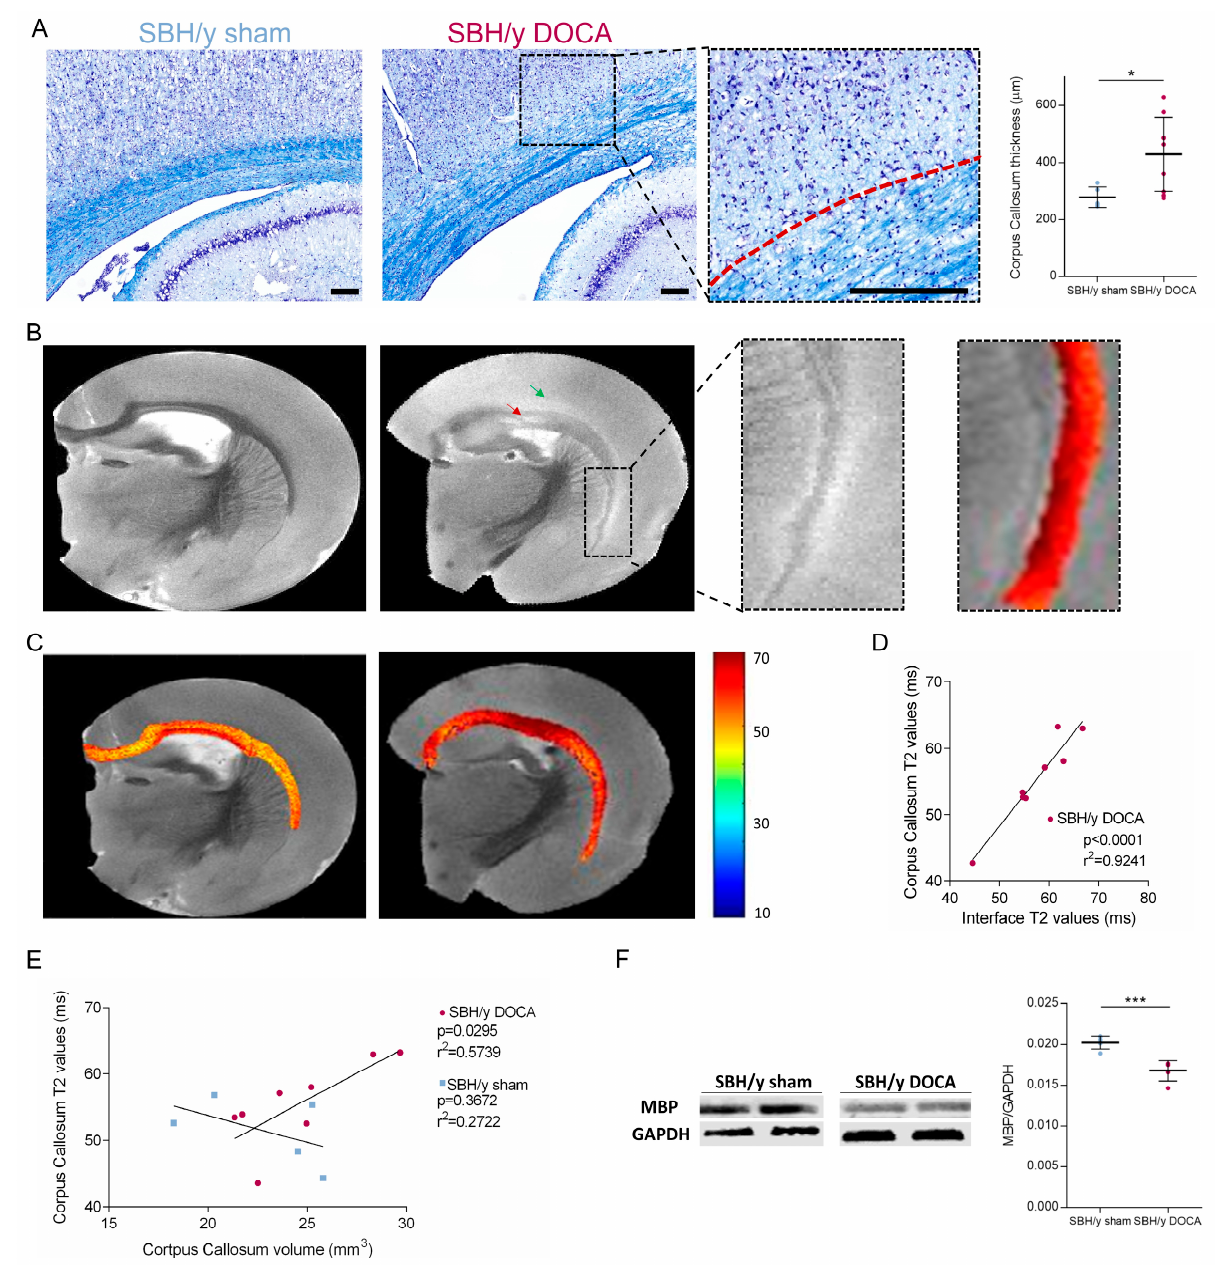
Figure 5. White matter pathology in SBH/y-DOCA brains. Representative luxol blue and cresyl violet staining of SBH/y sham and SBH/y-DOCA brains ( A ), and 5x magnification of the white matter–grey matter interface of SBH/y-DOCA (middle panel). Spotted red line in (middle panel in ( A )) identifies the border between the white matter and the grey matter. Quantification of corpus callosum thickness in SBH/y sham ( n = 5) and SBH/y-DOCA ( n = 9) brains (right panel). T2 images of SBH/y sham and SBH/y-DOCA ( B ). Red arrow on ( B ) marks WMH, and green arrow marks an ‘interface hyperintensity halo’. 4 × magnification of the white matter–grey matter interface of SBH/y-DOCA (middle panel in ( B )) and T2 values of the same region (right panel in ( B )). T2 values of corpus callosum of representative SBH/y sham and SBH/y DOCA brains ( C ). Correlation between T2 values in the white matter–grey matter interface and in the corpus callosum in SBH/y-DOCA rats ( n = 9) ( D ). Correlation between corpus callosum volume and T2 values in SBH/y sham and SBH/y- DOCA brains ( E ). Representative Western blot images and quantification ( F ) of MBP in of SBH/y sham ( n = 5) and SBH/y-DOCA ( n = 5) cortical extracts. Scale bars = 200 µ m. Data are presented as mean ± SD. * p < 0.05, *** p < 0.001. Two-tailed t -test analyses in ( A , F ). Pearson correlation in ( D , E